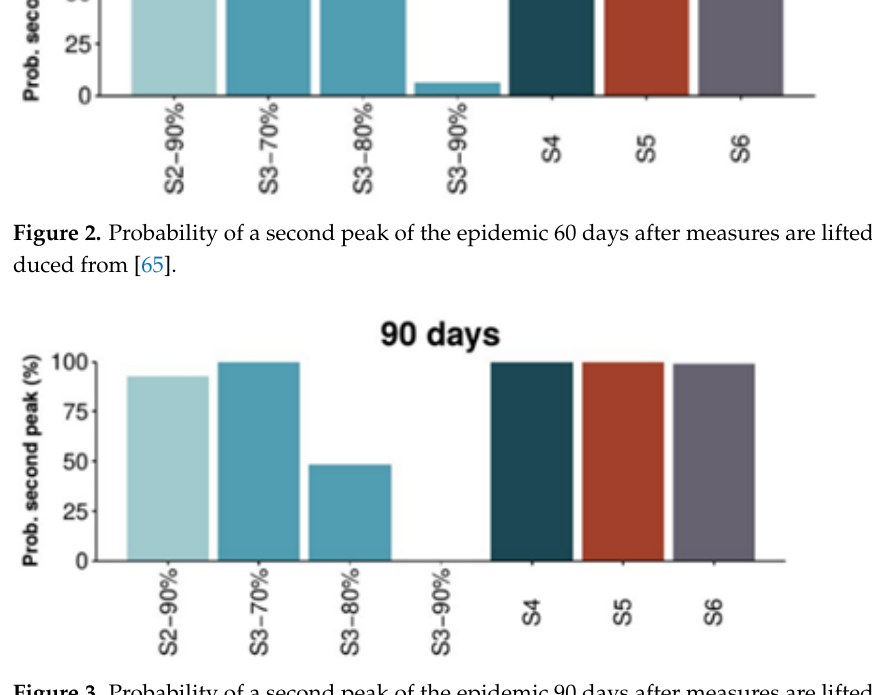
Figure 3. Probability of a second peak of the epidemic 90 days after measures are lifted [65]. Re- produced from [65].